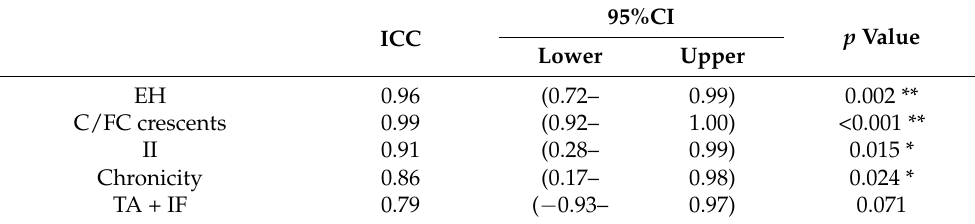
Table 3. Interclass correlation coefficient of different lupus nephritis pathology scores.